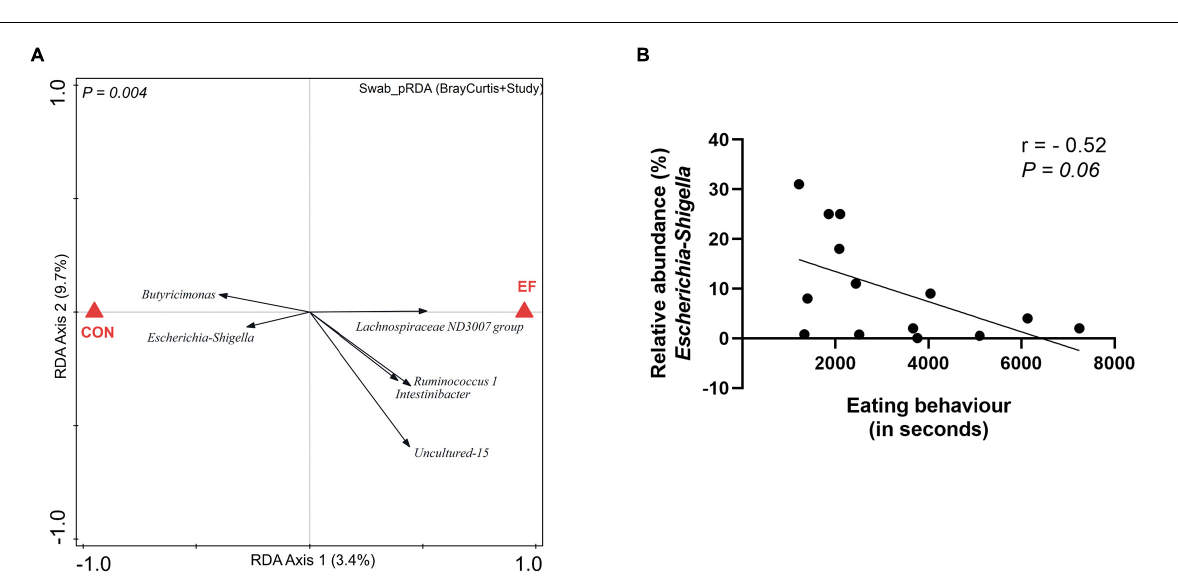
( r = 0.94, P < 0.0001) of their positioning in this analysis (CaseR score in the RDA, which we refer to as “predicted mucosity factor”) and the measured Bray Curtis distance relative